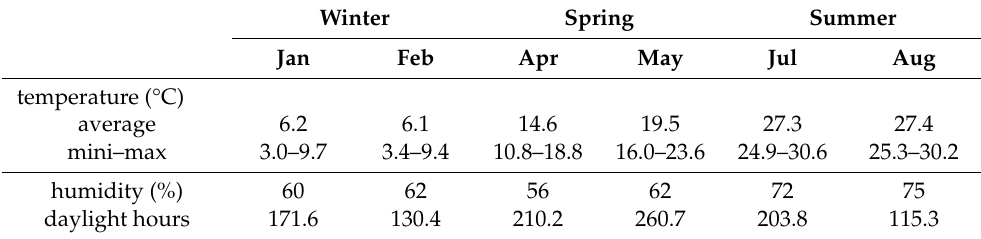
Table 1. Monthly average temperature, humidity, and daylight